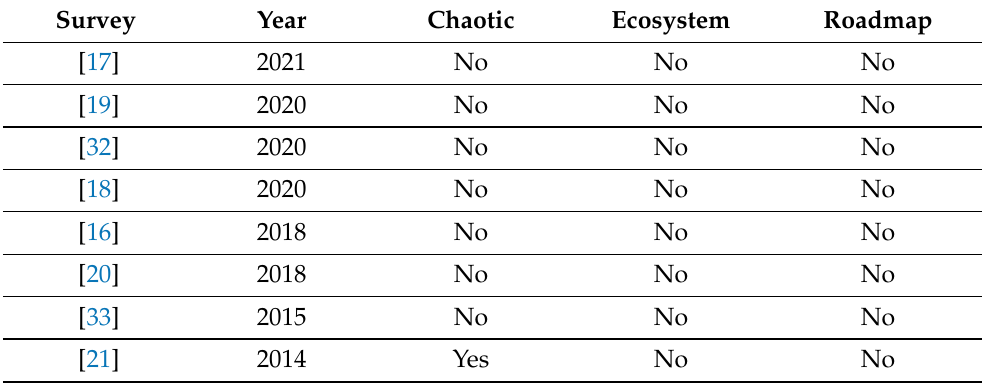
Table 1. Summary of Existing